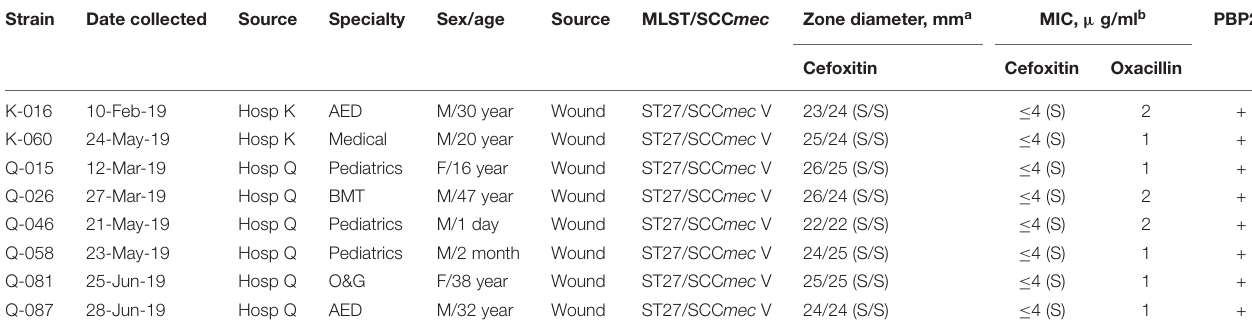
FIGURE 2 | Growth patterns of Staphylococcus lugdunensis strains and S. aureus controls on Muller-Hinton agar supplemented with 2% sodium chloride and 2 µ g/ml oxacillin using bacterial inoculum of 5 µ l: Positive control, S. aureus ATCC 43300; negative control, S. aureus ATCC 29213; and mecA -positive, cefoxitin-susceptible S. lugdunensis strains (K-016, K-060, Q-015, Q-026, Q-046, Q-058, Q-081, and Q-087). TABLE 2 | Summary of 8 mecA -positive interpreted as cefoxitin-susceptible by the CLSI M100, 30th edition S. aureus/S. lugdunensis breakpoint.